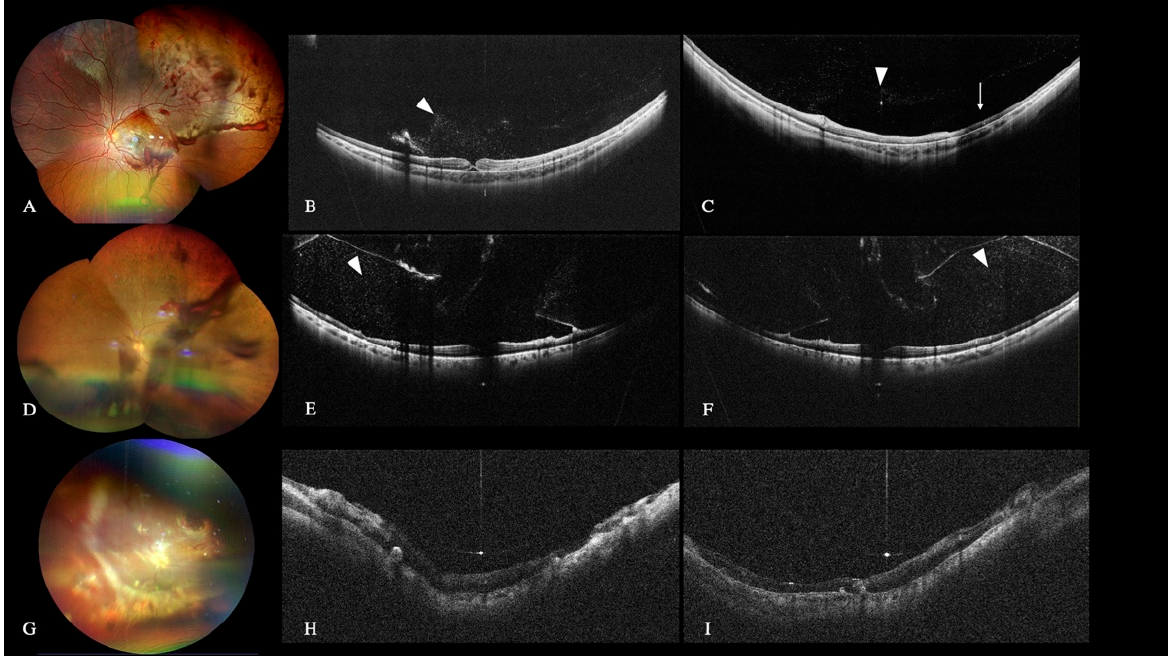
Figure 6. WF color fundus retinography ( A ) of an 11-year-old boy showed vitreous and preretinal